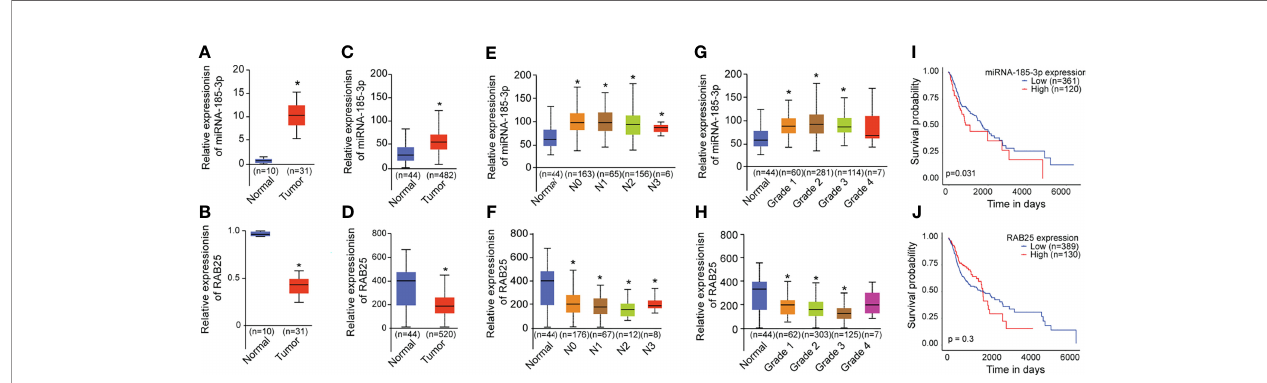
FIGURE 5 | miR-185-3p/RAB25 is deregulated and associated with poor prognosis in HNSCC. (A, B) mRNA expression of miR-185-3p and RAB25 in HNSCC tumor and adjacent tissues. (C, D) TCGA data showing the relative expression of miR-185-3p and RAB25 in HNSCC patients and normal ones. (E, F) TCGA data showing the relative expression of miR-185-3p and RAB25 in HNSCC patients with different node metastasis strati fi cation. (G, H) TCGA data showing the relative expression of miR-185-3p and RAB25 in HNSCC patients with different disease grade. (I, J) TCGA data showing the survival rate of miR-185-3p and RAB25 in HNSCC patients with different expression. * p <